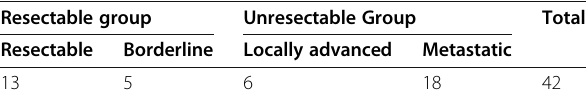
Table 4 Resectability of MDCT correlated with